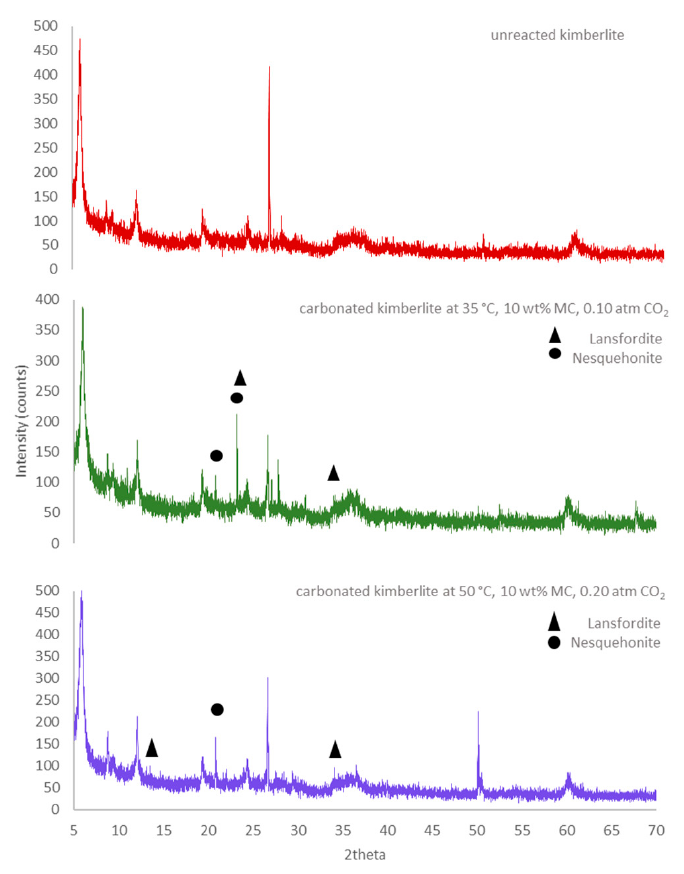
Figure 8. XRD diffractograms of unreacted kimberlite ( top ) and incubator carbonated (144 h) kimberlite at 35 °C, 10 wt% moisture content and 0.10 atm CO 2 ( middle ), and at 50 °C, 10 wt% moisture content, and 0.20 atm CO 2 ( bottom ).